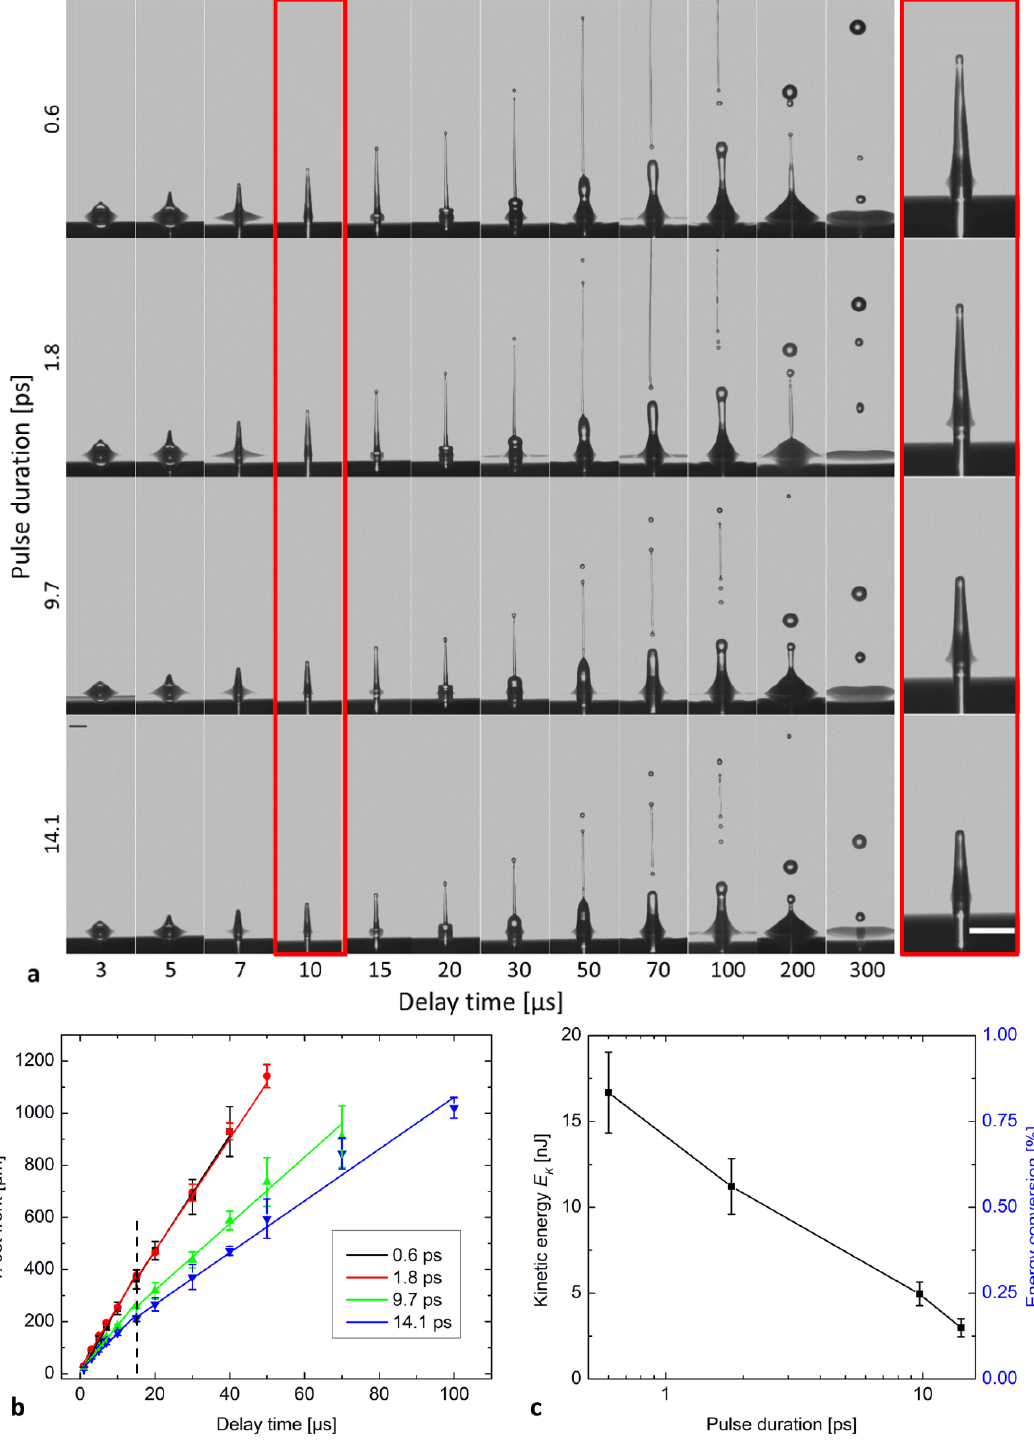
Figure 3. ( a ) Time-resolved images of laser-induced jets in variation of pulse duration, at a constant pulse energy of 2 µ J and focus depth of 52 µ m. Scale bar is 100 µ m. ( b ) Jet front position versus the delay time at different pulse durations. ( c ) Kinetic energy of hydrogel jets and corresponding conversion efficiency relative to incident pulse energy of 2 µ J at a delay time of 10 µ